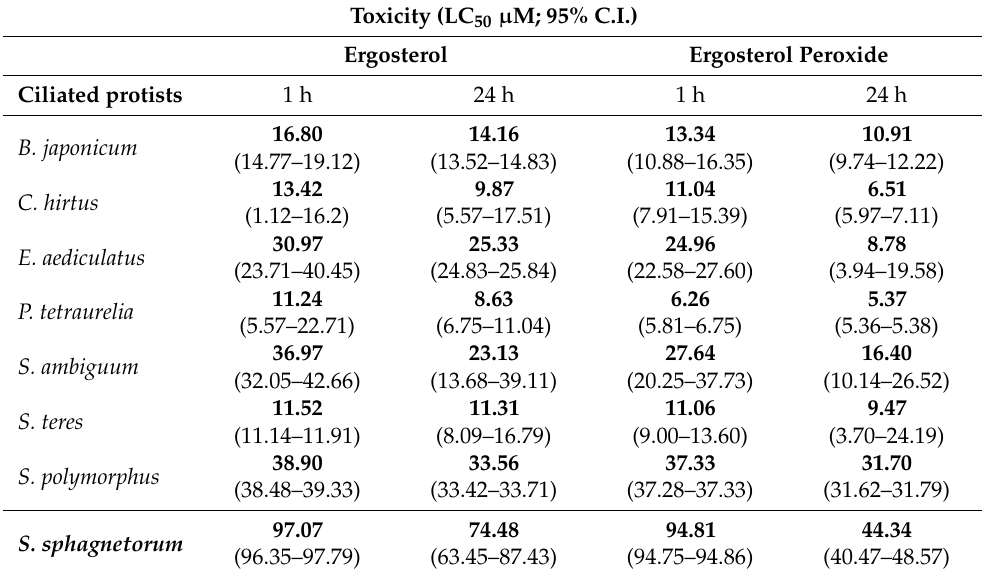
Table 1. Comparison of the cytotoxic effects of ergosterol and ergosterol peroxide on seven ciliate species and the microturbellarian S. sphagnetorum . Viability was assessed after 1 or 24 h of incuba- tion and the LC 50 values were obtained by a nonlinear regression analysis of three independent experiments with the 95% confidence limits calculated using GraphPad Prism 6